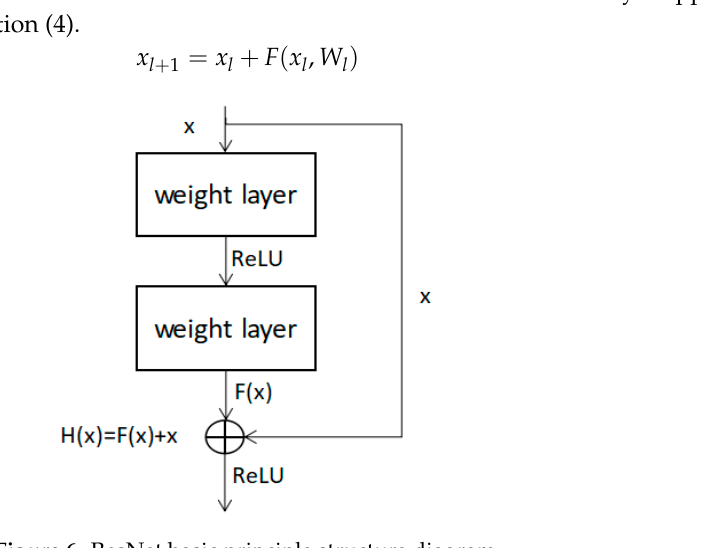
Figure 6. ResNet basic principle structure diagram.